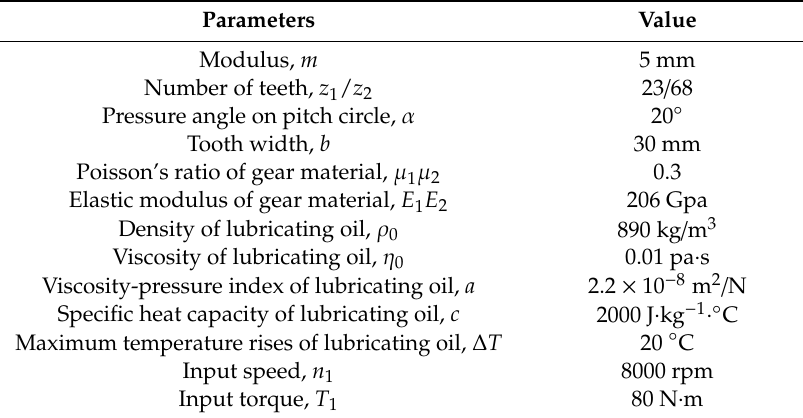
Table 1. Parameters for simulation.